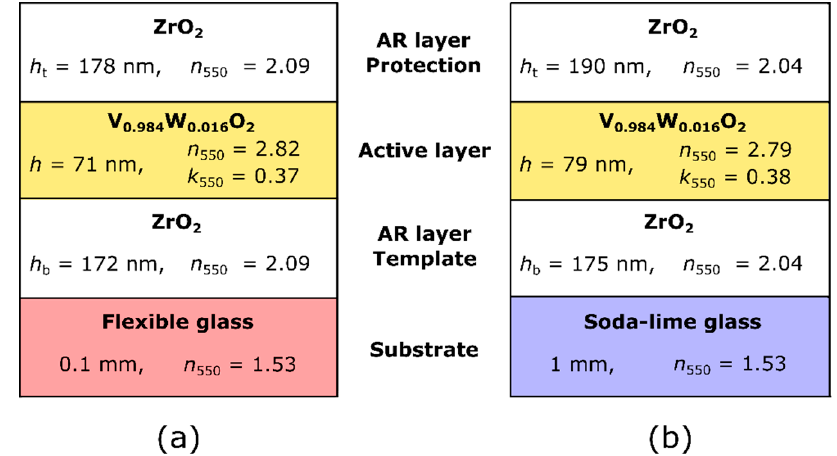
Figure 3. The three-layer thermochromic VO 2 -based coatings on ultrathin flexible glass (a) and soda-lime glass (b) substrates investigated in this paper. Here, h b , h , and h t represent the thickness of the bottom ZrO 2 layer, the thickness of the active V 0.984 W 0.016 O 2 layer, and the thickness of the top ZrO 2 layer, respectively. The refractive index ( n 550 ) and extinction coefficient ( k 550 ) at the wavelength of 550 nm of all layers were measured at T m = 23 °C.